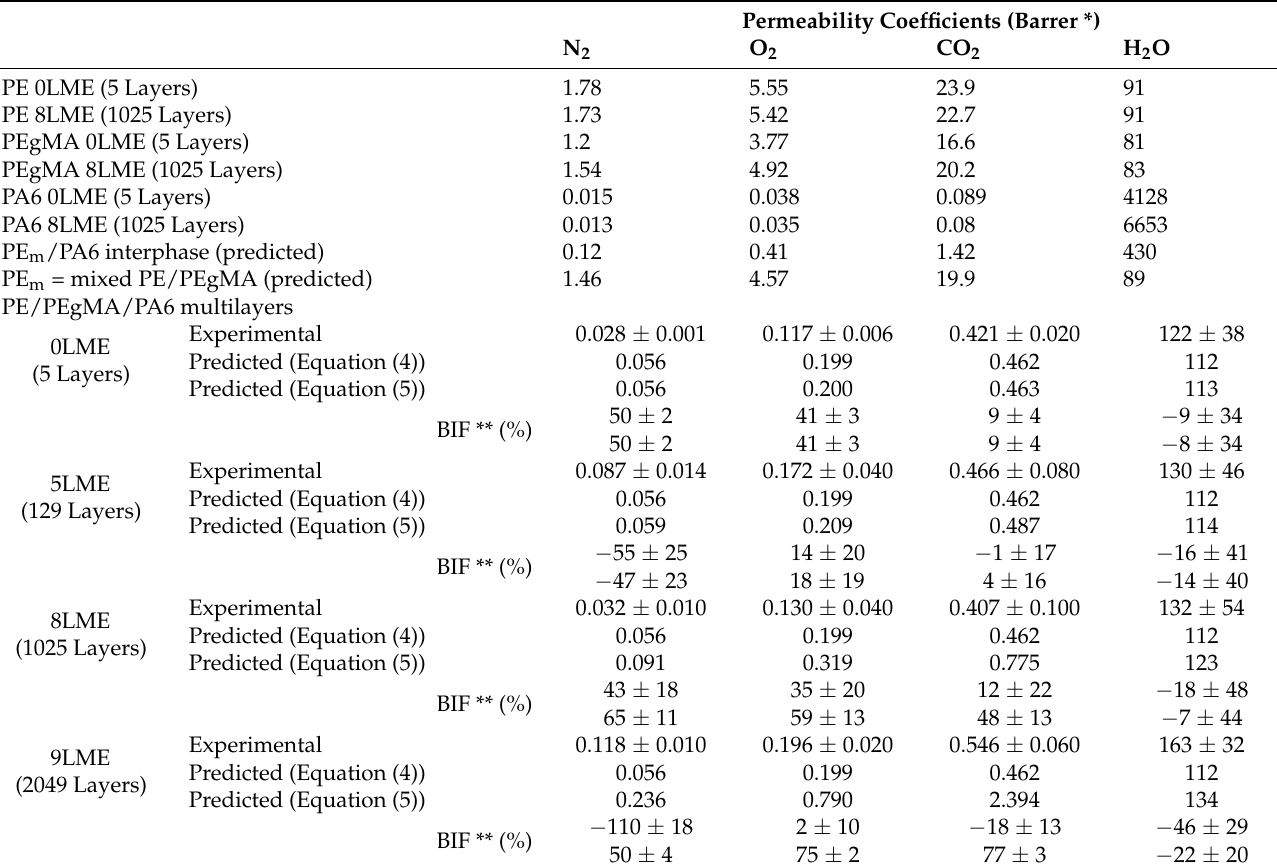
Table 2. Experimental and predicted values of gas and water permeability coefficients for PE, PEgMA, PA6 with 0LME and PE/PEgMA/PA6multilayer films extruded with 0, 5, 8 and 9 LME. The predicted values are calculated from the serial model without (Equation (4)) or with an interphase (Equation